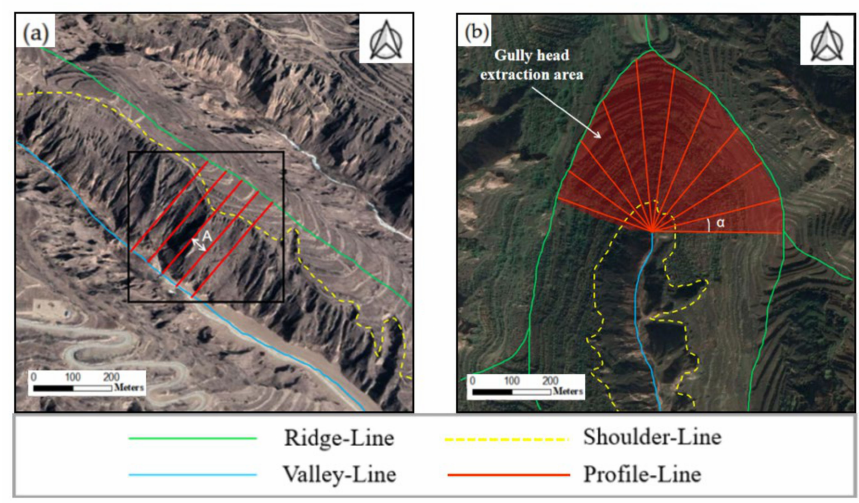
Figure 7. Schematic diagram of raster profile extraction: ( a ) at the gully sidewalls; ( b ) at the gully head.